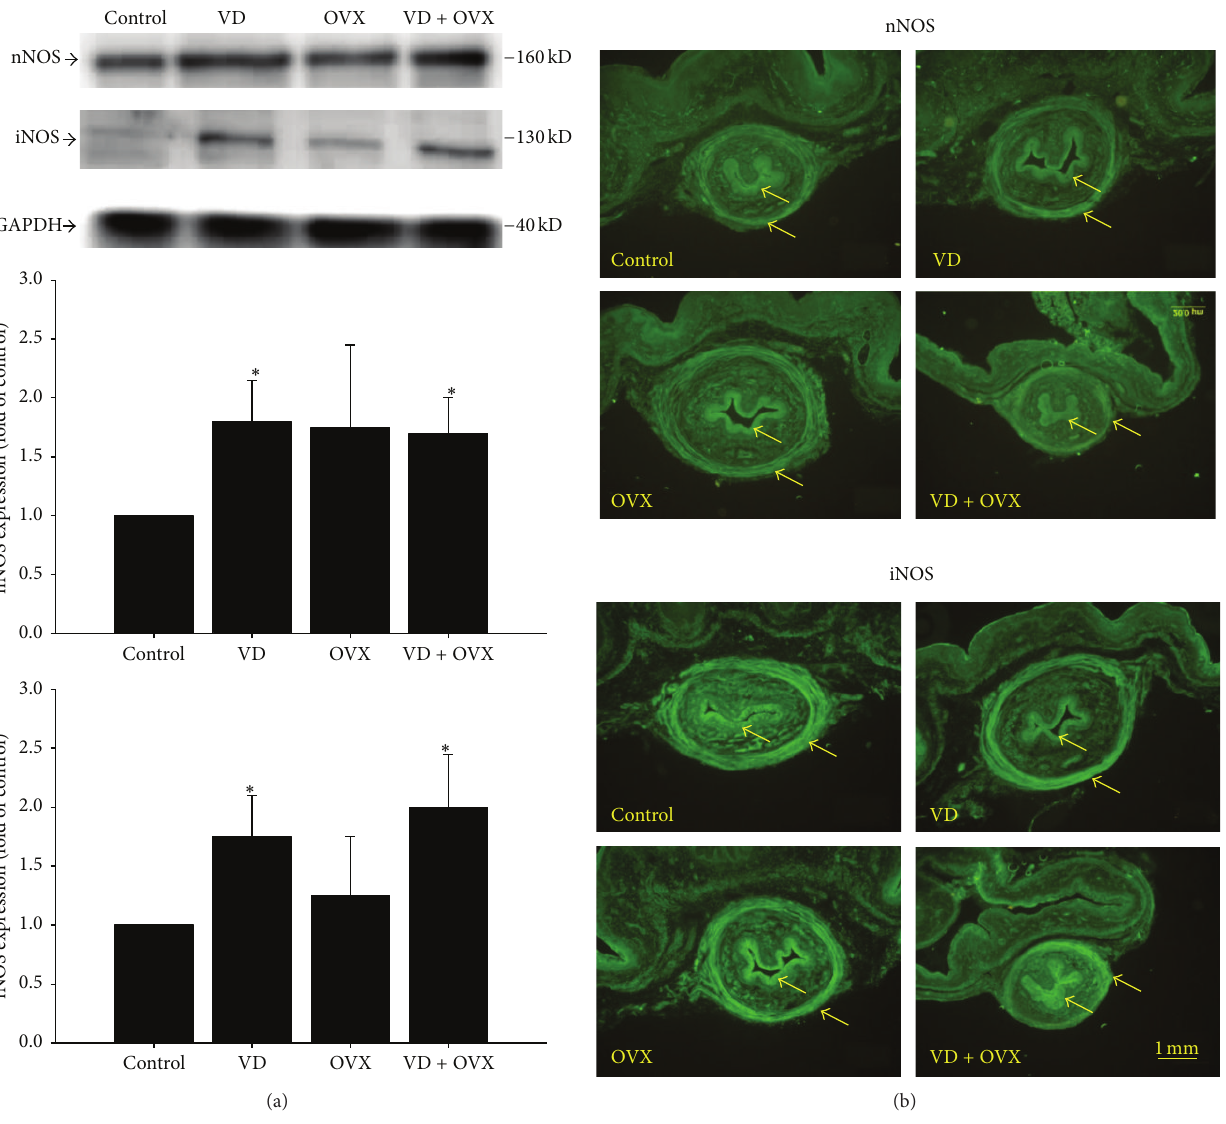
Figure 4: nNOS and iNOS expressions in the transverse sections of the midurethra as indicated by (a) Western blot and (b) immunofluorescence staining in the different groups. The values are calculated by fold of control and expressed as mean ± SEM of six individual mice. ∗ 𝑃 < 0.05 compared to control